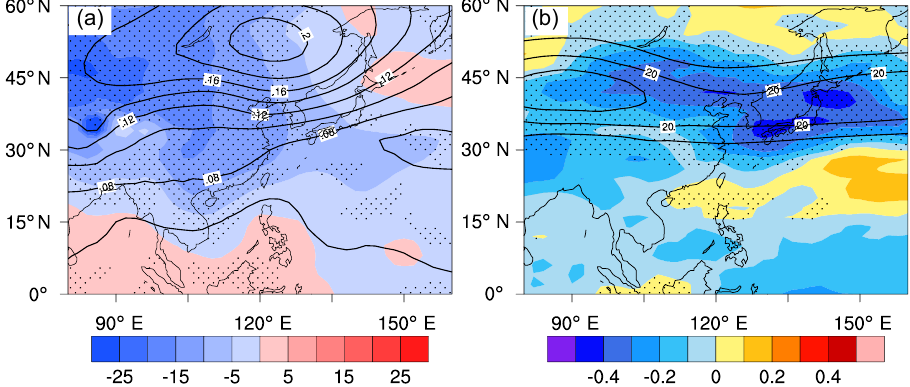
Figure 3. (a) MEM of differences in the summer surface air temperature (contours, in ◦ C) and sea level pressure (shading, in Pa) between the MCA and LIA; (b) MEM of differences in the summer 200hPa zonal winds (shading, ms − 1 ) between the MCA and LIA. Red contours are the climatological (850–1850AD) 200hPa zonal winds ( ≥ 15ms − 1 , contour interval is 5ms − 1 ). Areas passing the 95% significance test are